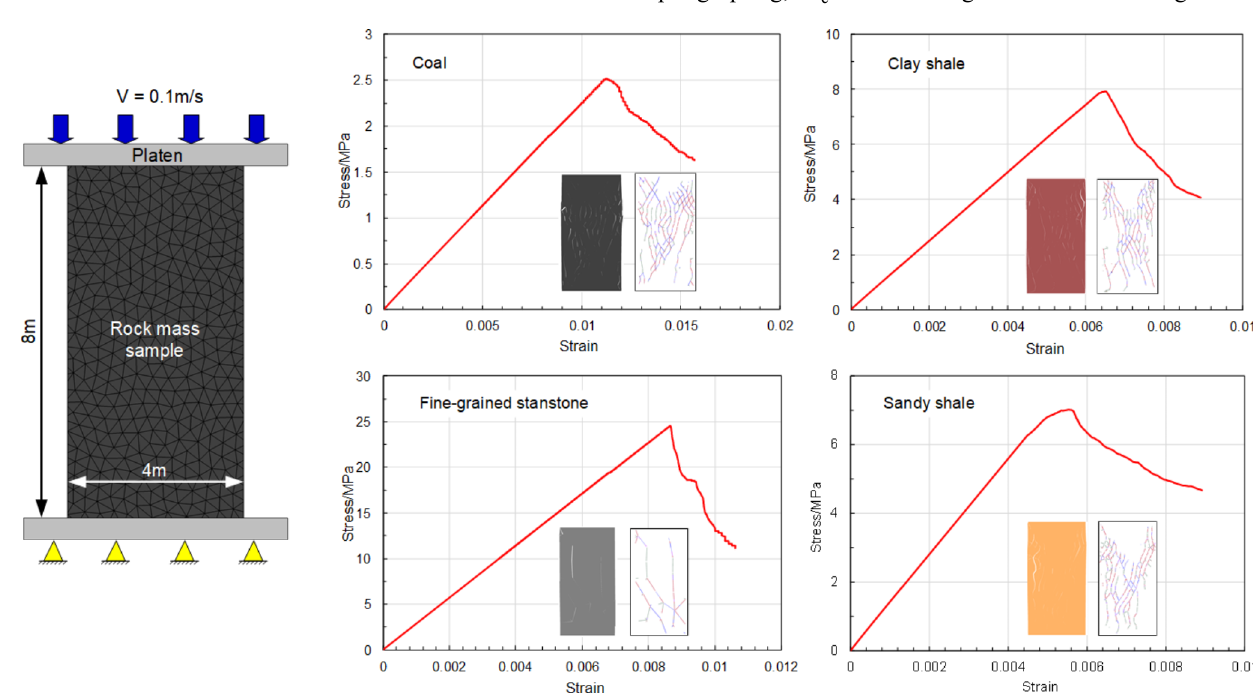
Fig. 6 Simulated failure modes and stress-strain curves of rock mass samples